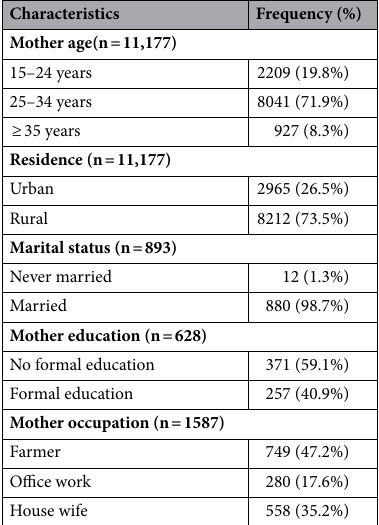
Table 1. Socio-demographic characteristics of newborn baby’s mothers delivered at Felege-Hiwot Comprehensive Specialized Referral hospital, from Sept. 2009 to Aug. 2014, Bahir Dar,